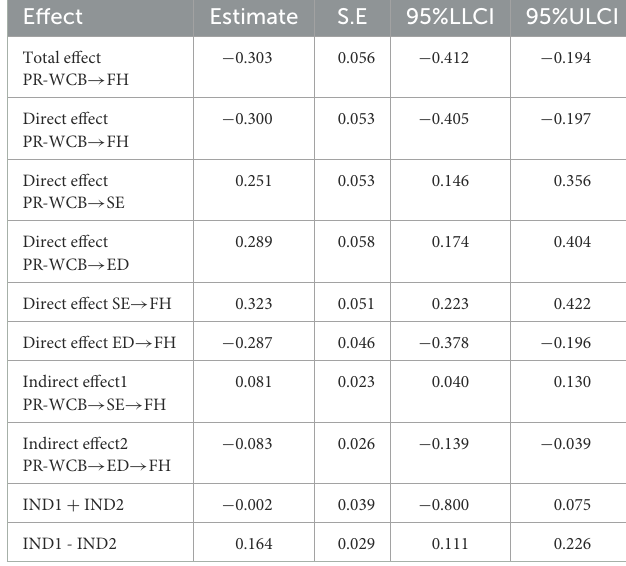
TABLE 8 Results of multiple mediating effects